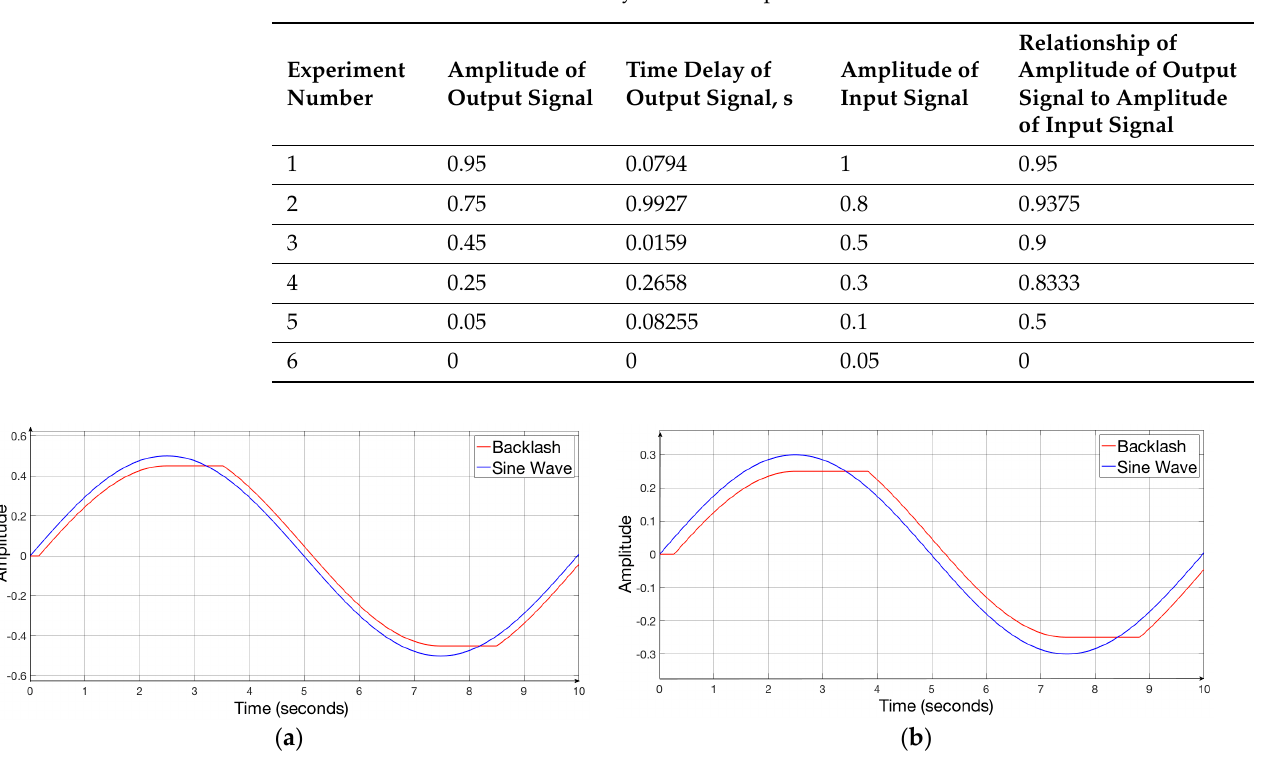
Table A2. Initial data and data analysis of both experiments.